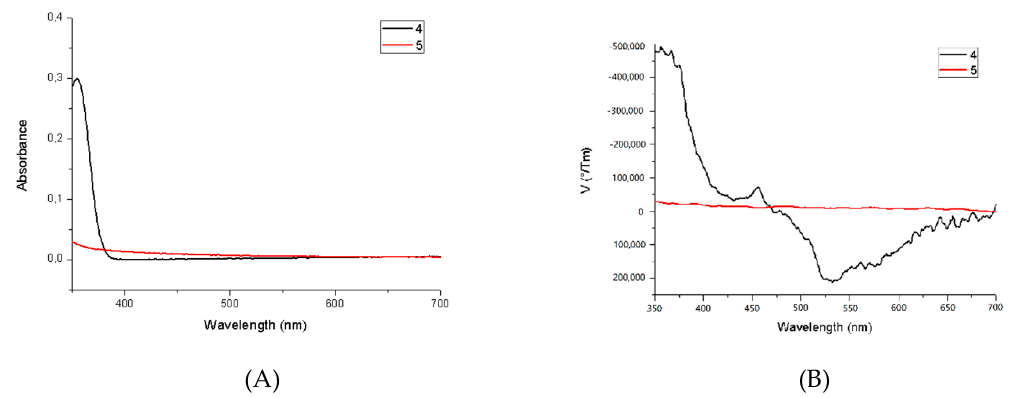
Figure 4. UV-Vis ( A ) and Faraday rotation spectrum ( B ) of 4 and 5.